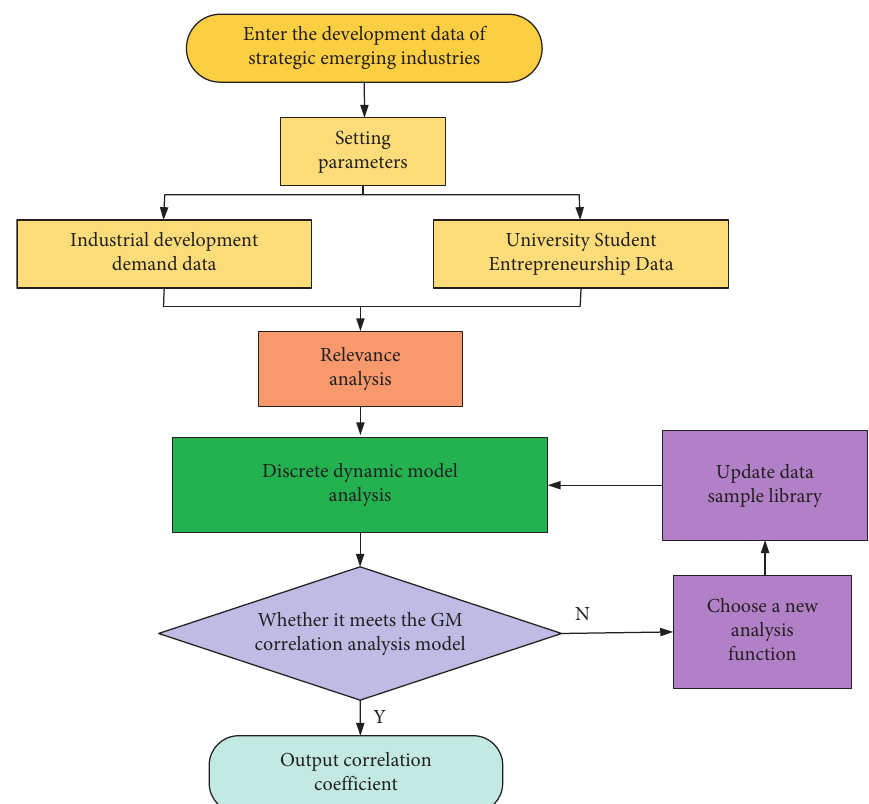
Figure 2: GM correlation model calculation process of data